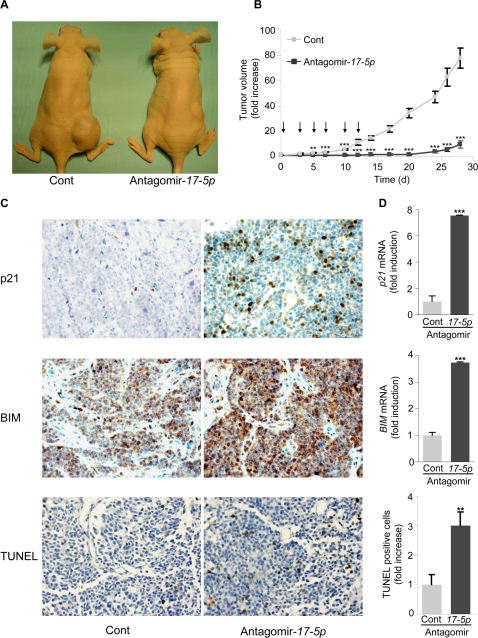
Treatment of MYCN-amplified LAN5 cells with antagomir-17-5p inhibits in vivo tumorigenesis through p21 and BIM upmodulation.(A) Nude mice were injected with MYCN-amplified LAN-5 cells and treated when tumors reached 150 mm3 with antagomir-17-5p or a control antagomir for 2 weeks. Representative mice were photographed four weeks after the first injection. (B) Growth curves of LAN-5 tumors treated with antagomir-17-5p or a control antagomir for 2 weeks (injections of antagomirs are indicated by arrows). The volume of the tumors was measured three times weekly and is plotted as the fold increase relative to the day of the first antagomir injection (day 0), set as 1. Mean±s.e.m. (n = 11 for cont; n = 10 for Antagomir-17-5p). (C) Immunohistochemistry on LAN-5 tumors treated with antagomir-17-5p or a control antagomir for 24 h. Sections derived from tumors were incubated with an anti-p21 antibody (upper panels), an anti-BIM antibody (middle panels) or with TUNEL for detection of apoptotic cells (lower panels). Representative fields are shown. (D) qRT-PCR of p21 (upper panel) or BIM (middle panel) mRNA levels in tumors formed by LAN-5 cells and treated with antagomir-17-5p or a control antagomir for 24 h. Mean±s.d. (n = 3). Lower panel. TUNEL positive cells in tumors treated with antagomir-17-5p or a control antagomir for 24 h. Mean±s.e.m. (n = 16). ** P<0.01, *** P<0.001.